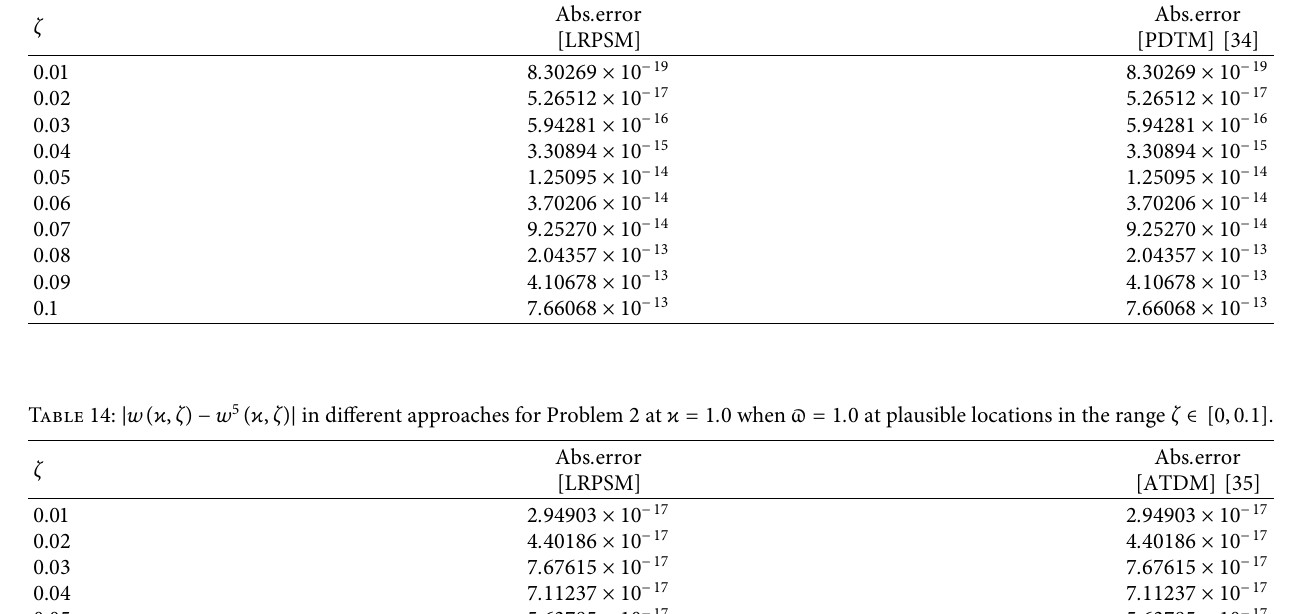
Table 13: | w ( ϰ , ζ ) − w 5 ( ϰ , ζ )| in diferent approaches for Problem 1 at ϰ � 0 . 002 when ϖ � 1 . 0 at plausible locations in the range ζ ∈ [ 0 , 0 . 1 ] . ζ